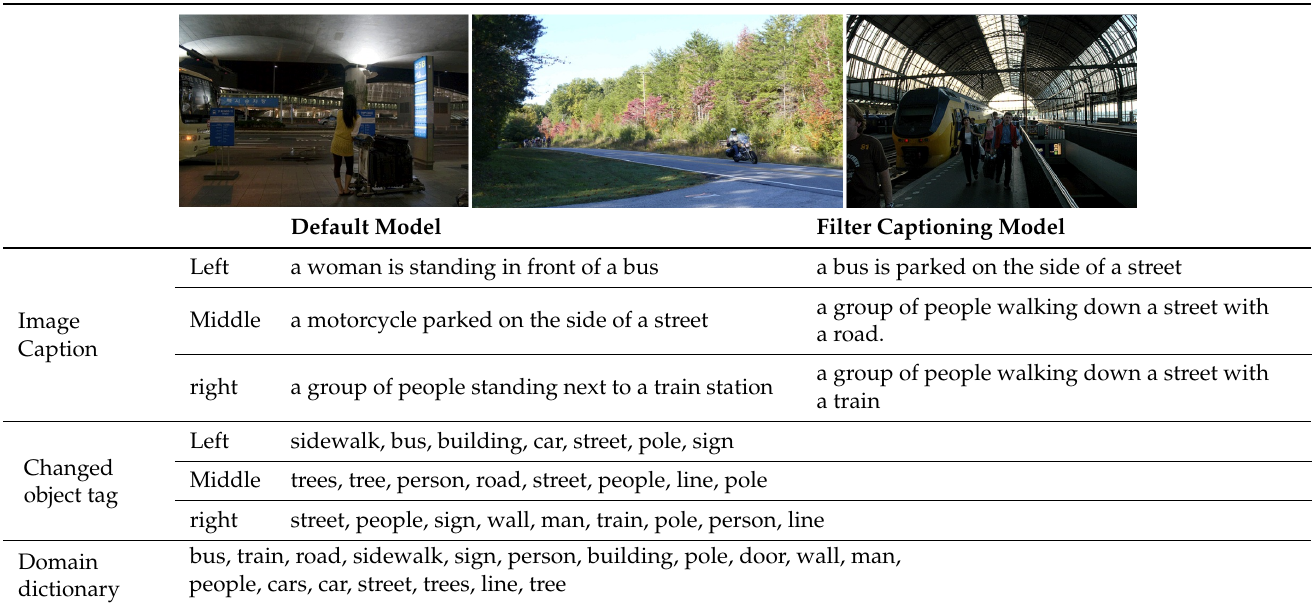
Figure 6. To show the difference in performance from the base model, visualization of BLEU, ME- TEOR, ROUGE_L, and CIDEr score is shown by subtracting the filter captioning score from the default model score. Table 4. This is an example of applying the filter captioning Model by constructing a domain dictionary for the visually impaired. The default model in the left picture depicts a person, but the filter captioning model depicts a relatively dangerous bus, and the central picture describes not only one motorcycle passing by, but also many motorcycles coming from the back of the road. The picture on the right comprehensively explains the situation of people and